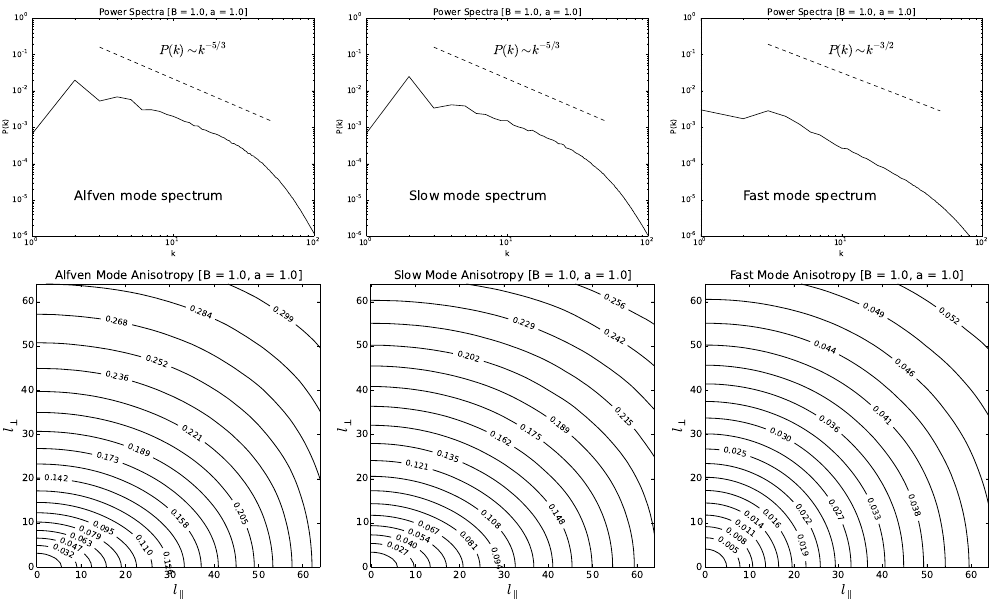
Fig. 2. Spectra and second-order structure function anisotropy of dispersion ( δv ) of the different wave modes in MHD turbulence. The Alfvén and slow modes present the K41 power cascade and strong anisotropy of dispersion of velocity at small scales, while the fast waves present the IK cascade and are basically isotropic at all scales. Data from a 1024 3 isothermal, sub-Alfvénic and subsonic turbulence model. instabilities (firehose, mirror and cyclotron instabilities) are small scales .